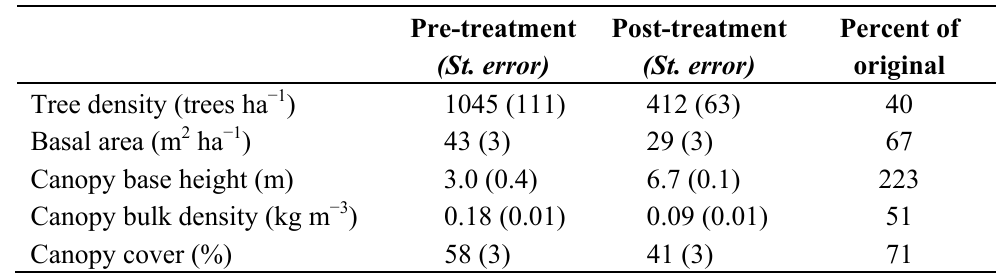
Table 1. Forest characteristics before and after treatment in Meadow Valley; plots (46) were measured before and after treatment, metrics were calculated with FVS [59], and the resultant change is shown; ladder fuel reduction is indicated by (1) an increase in CBH and (2) a large reduction in trees ha − 1 paired with a relatively smaller reduction in basal area (many trees were removed, but most were small).